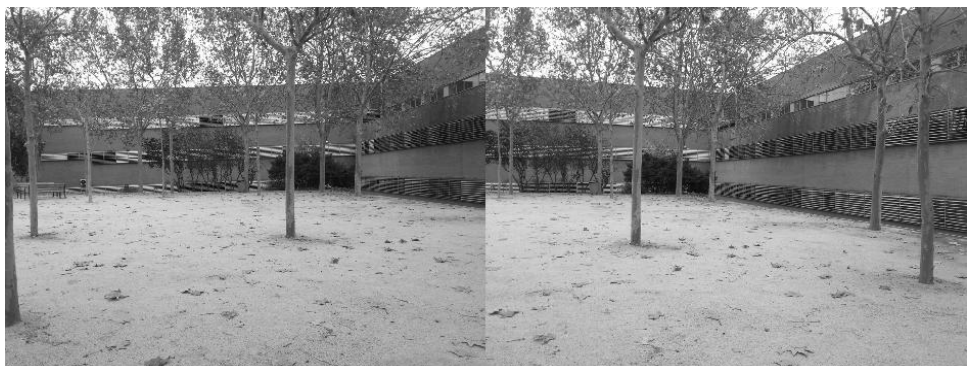
Figure 2. Pair of images captured at experimental